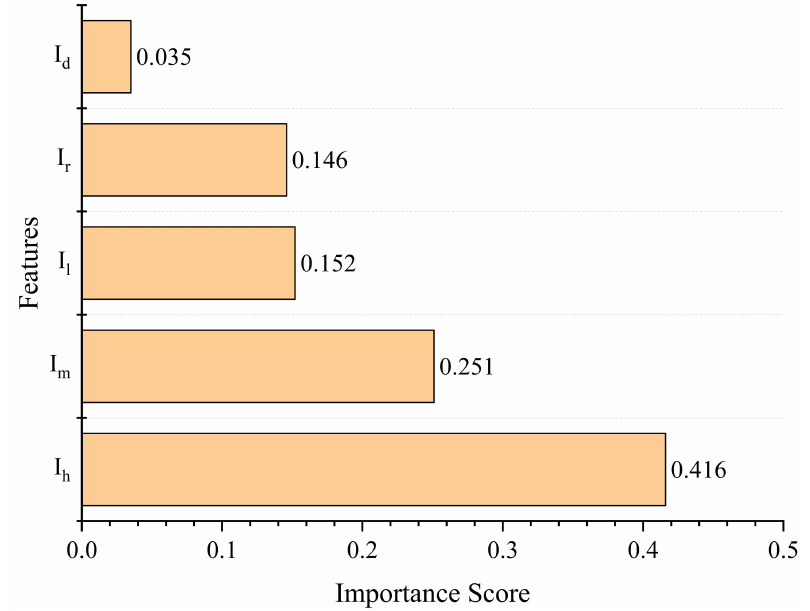
Figure 12. Importance scores of input features.